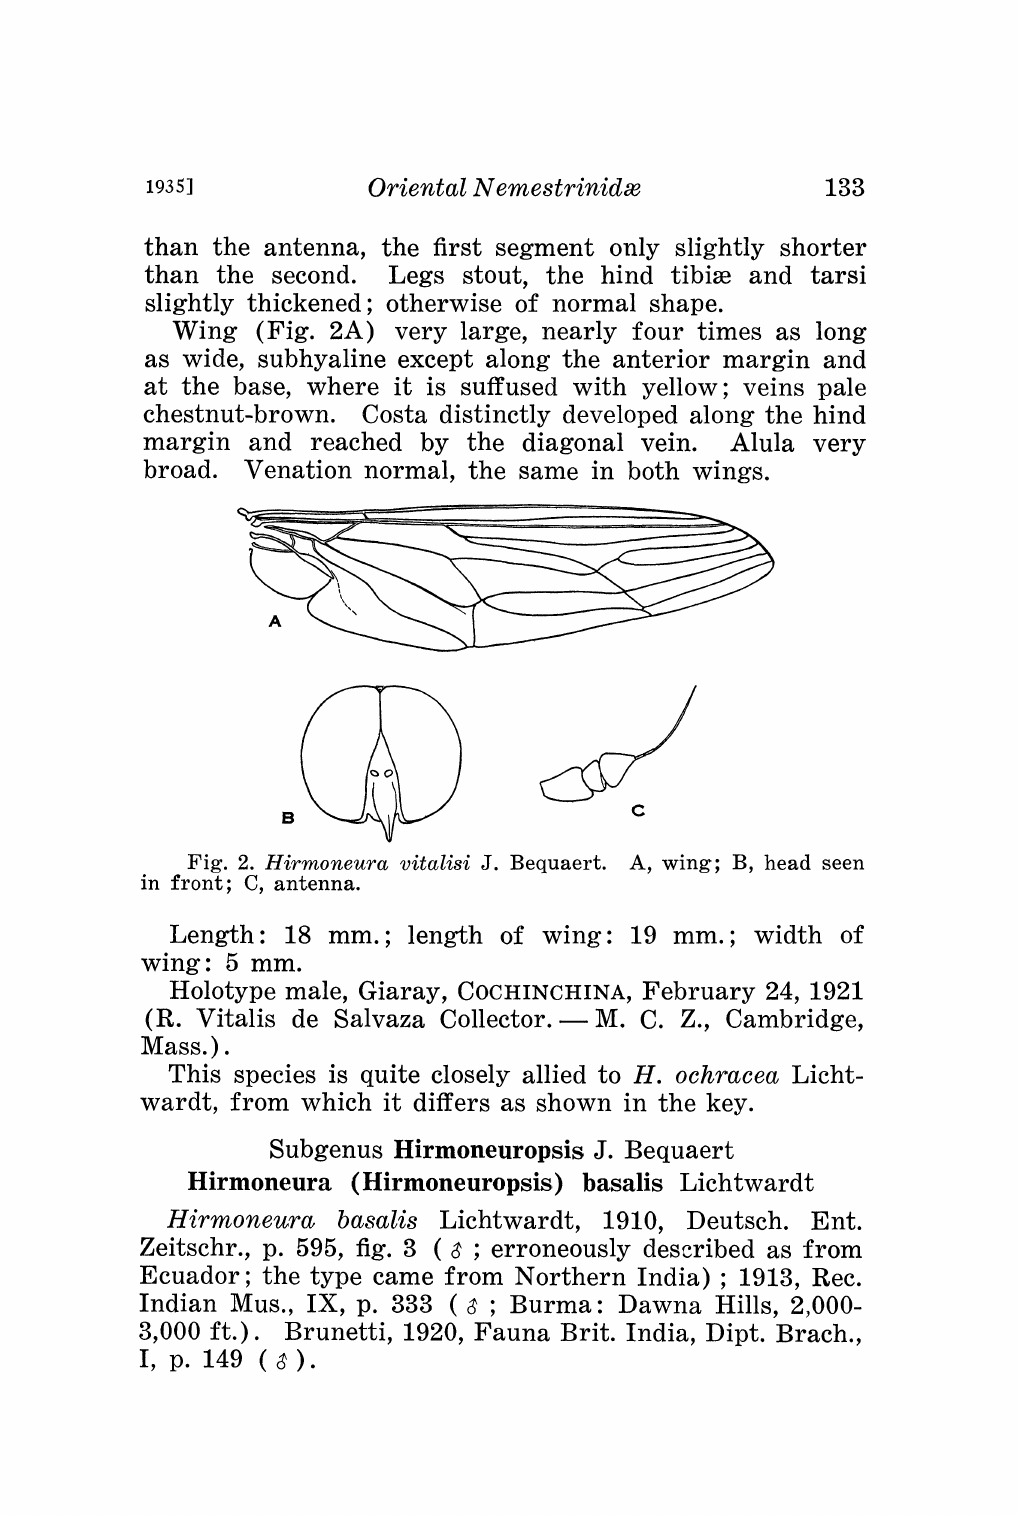
Fig. 2. Hirmoneura vitalisi J. Bequaert. A, wing; B, head seen in front; C, antenna. Length: 18 mm.; length o wing: 19 mm.; width of wing" 5